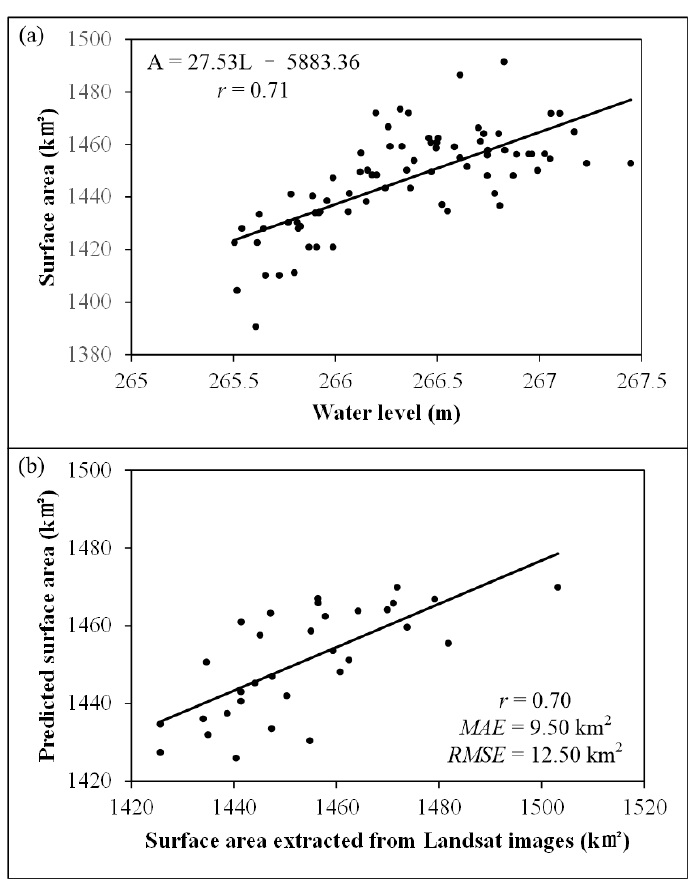
Figure 12. The water level-surface area ( L-A ) curve retrieved for the SPLC ( a ); and its accuracy for lake surface area estimates ( b ).